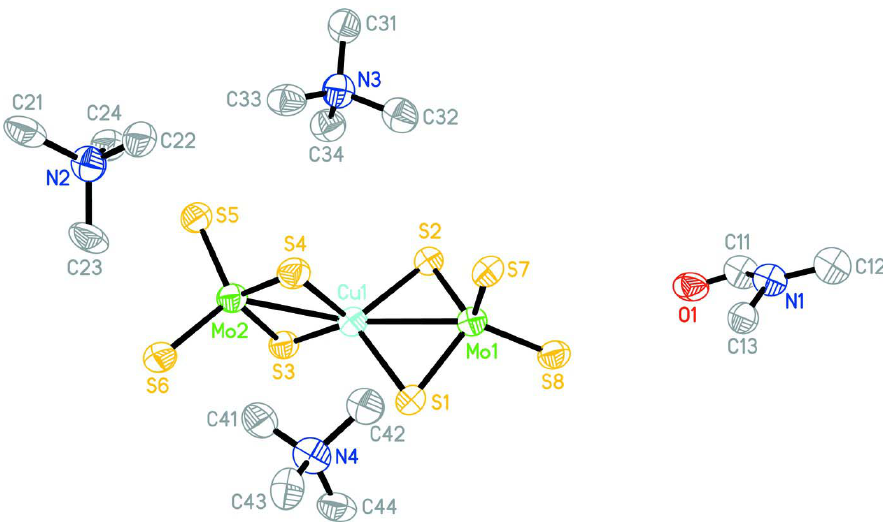
The molecular structure of the title compound, with atom labels and 50% probability displacement ellipsoids. All H atoms have been